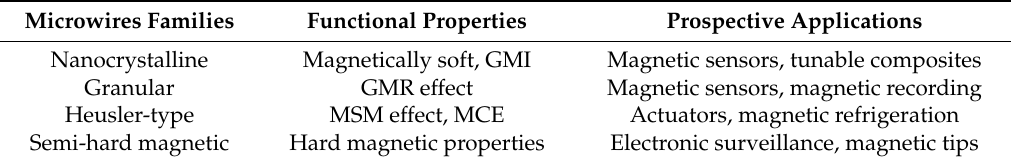
Table 1. Functional properties and prospective applications of microwire families analyzed in this work. Microwires